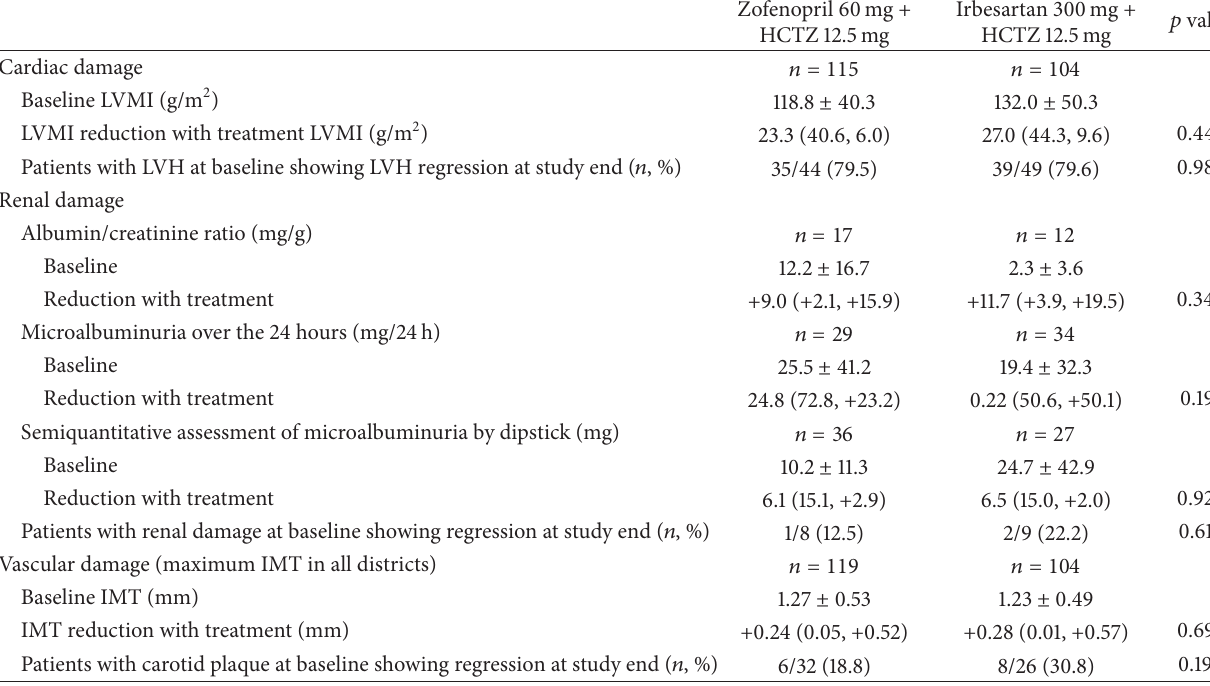
Table 5: Summary measures for cardiac (LVMI, left ventricular mass index), renal (urine protein), and vascular (IMT, intima-media thickness) damage after 48 weeks of treatment with zofenopril 60 mg + hydrochlorothiazide (HCTZ) or irbesartan 300 mg + HCTZ. Data are shown for the intention-to-treat population. For any measure the baseline value ( ± SD), the adjusted reduction (and 95% confidence interval), and the absolute ( 𝑛 ) and relative (%) frequency of patients with damage at baseline showing regression with treatment are reported. Adjustment was made by the baseline value and other potentially confounding variables (age, gender, abdominal obesity, HDL cholesterol, family history for premature cardiovascular disease, baseline blood pressure, and blood pressure changes with treatment). The 𝑝 value refers to the statistical significance of the intertreatment